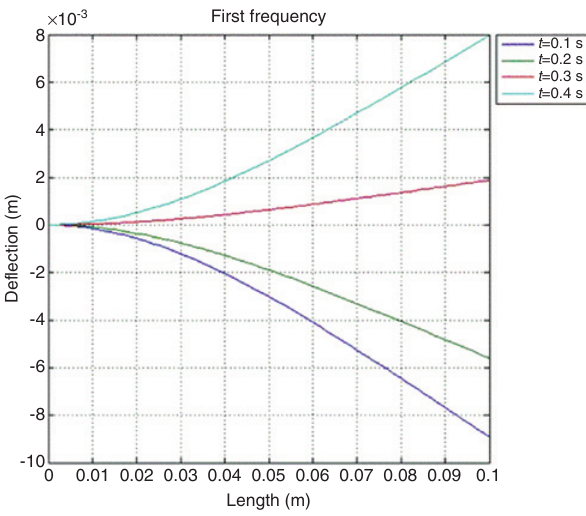
Figure 3: Vibrations of first characteristic mode of the cantilever beam.